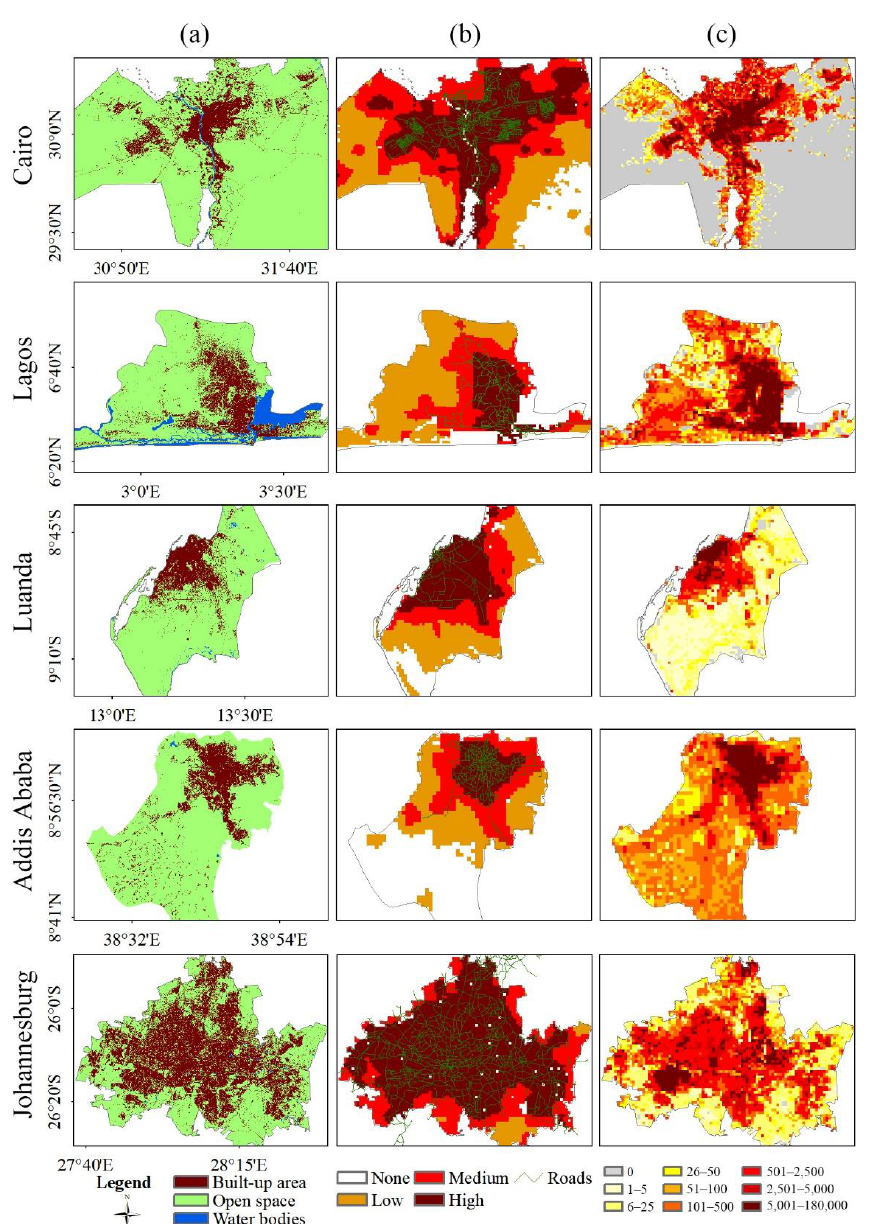
Figure 10. Comparative analysis of ( a ) urban land use, ( b ) nighttime lighting areas and arterial roads, and ( c ) population density.